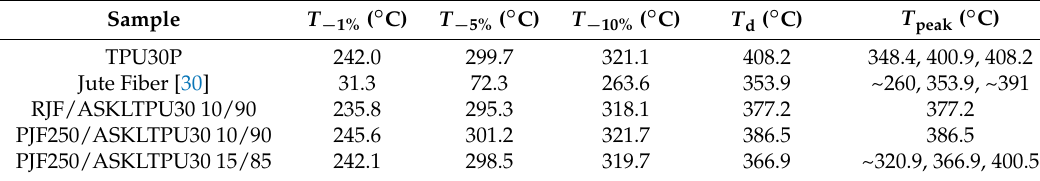
Figure 8. ( a ) TGA and ( b ) derivative of the TGA (DTG) results of ASKLTPU30P. Table 3. TGA and derivative of the TGA (DTG) results of JF-reinforced